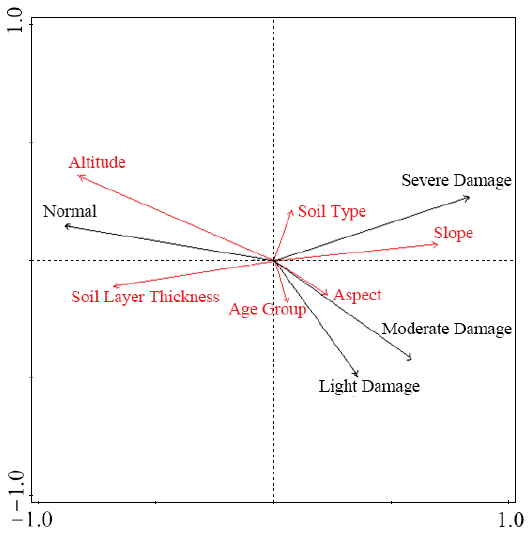
Figure 9. The CCA ranking chart for the damage degree of Picea asperata forests and impact